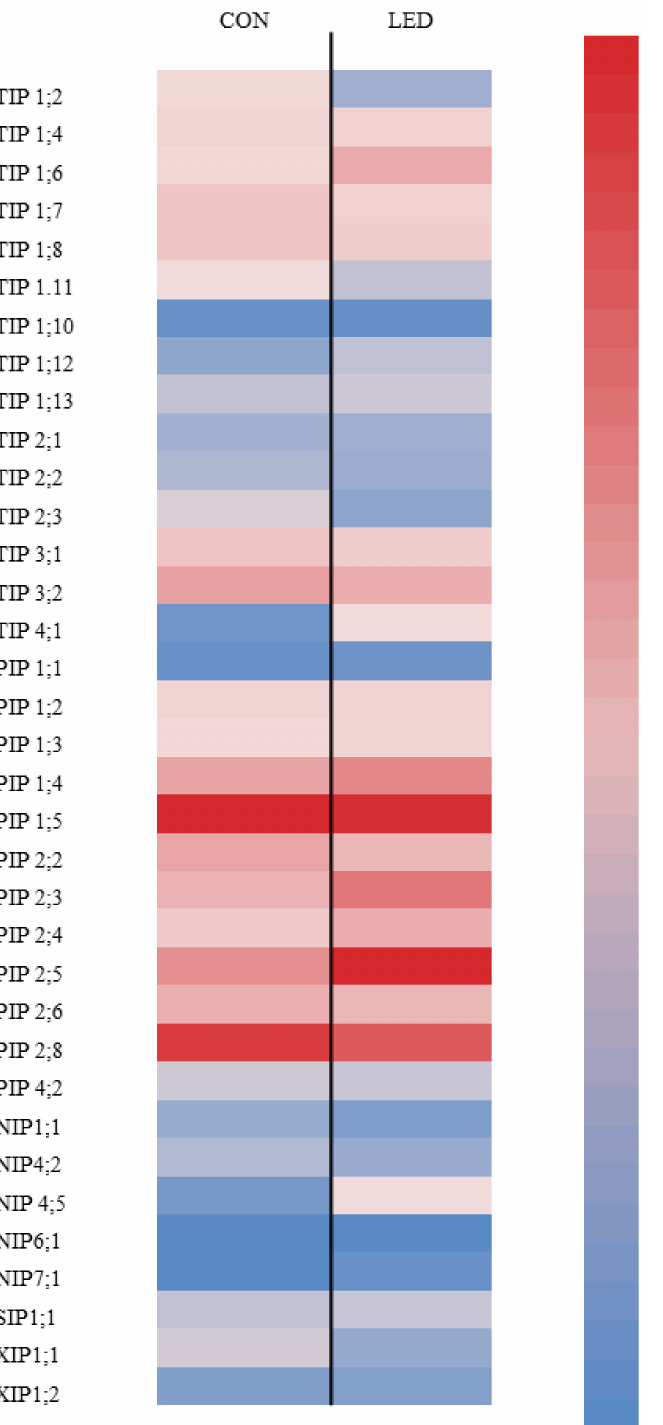
Figure 3. Heat-map representation of TIP , PIP , NIP , SIP , and XIP isoforms expression in Control (CON, unlighted) and irradiated R LED (LED) pepper seeds, after radicle emergence during germina- tion (at 96 h of imbibition), as compared to the NIP1;1 (lower expression) of each treatment. Data are means of three repetitions ( n =